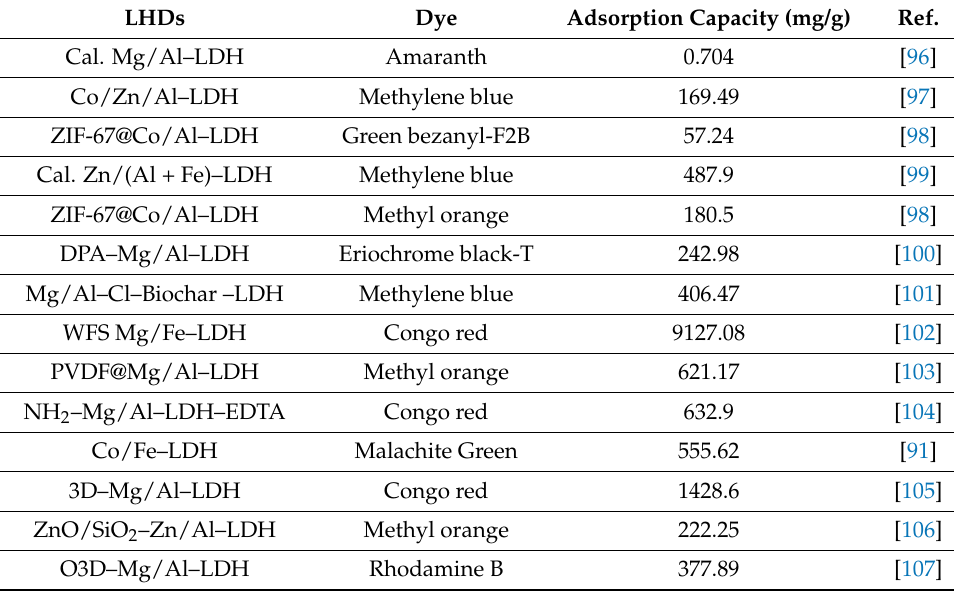
Table 2. Previously reported LDHs for different dye adsorptions.